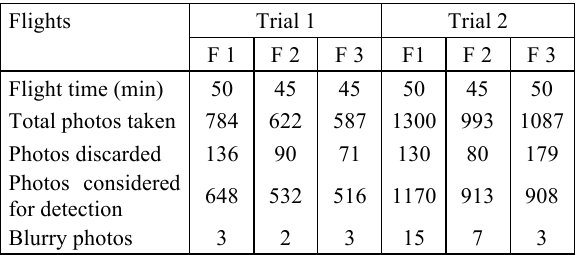
Table 6. Number of photos taken during each flight and